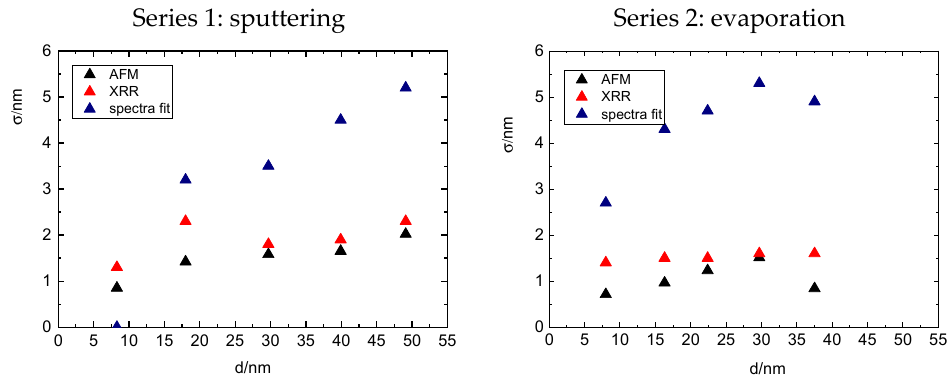
Figure 6. Rms roughness σ of the alumina overlayer vs. aluminum thickness d as obtained from XRR.